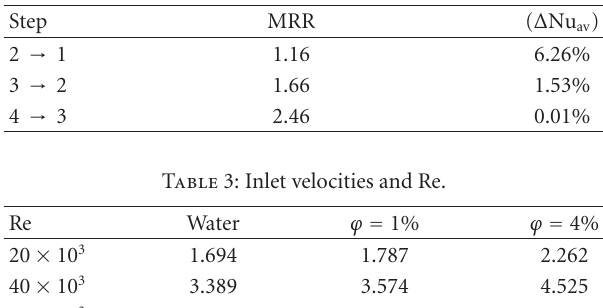
Table 2: MRR and di ff erences in terms of Nu among the di ff erent tested meshes.